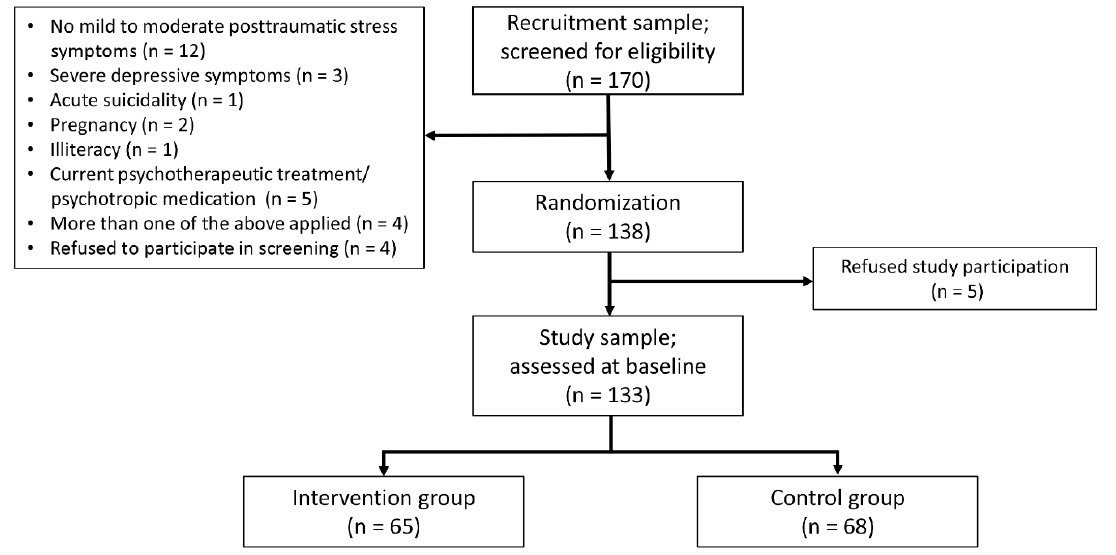
Figure 1. Flow chart of the recruitment process and sample selection.